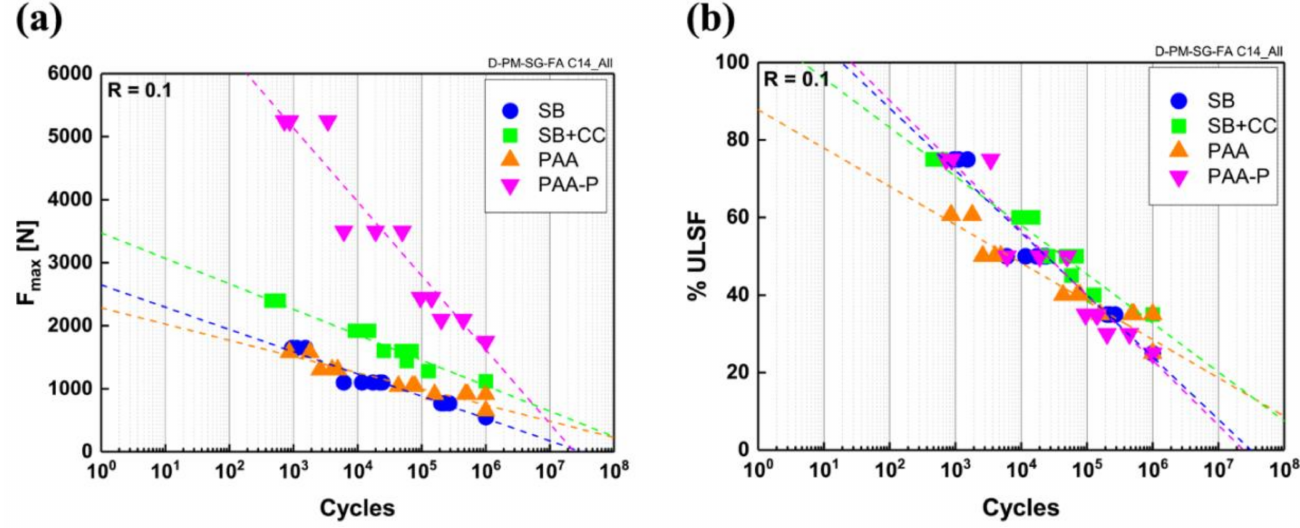
Figure 4. ( a ) S–N curves of the various surface-pre-treatment specimens based on the exponential model. Reprinted from [7] with permission; Copyright Springer Nature 2021. ( b ) S–N curves of the specimens as a percentage of their initial quasi-static strength (ultimate lap shear